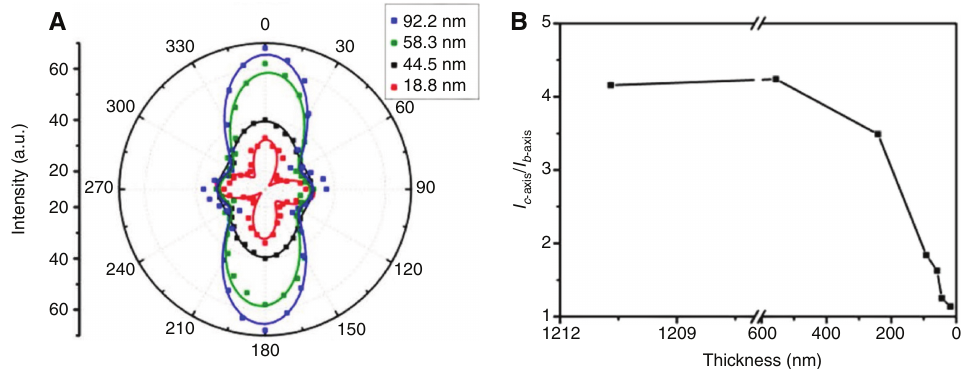
Figure 15: Thickness-dependent SHG responses of 2D perovskite. (A) Polar SHG intensity plots of the 2D [(C solid curves indicate the theoretical fits. (B) SHG intensity anisotropy ( I Reprinted from Ref. [189] with permission from the American Chemical Society.